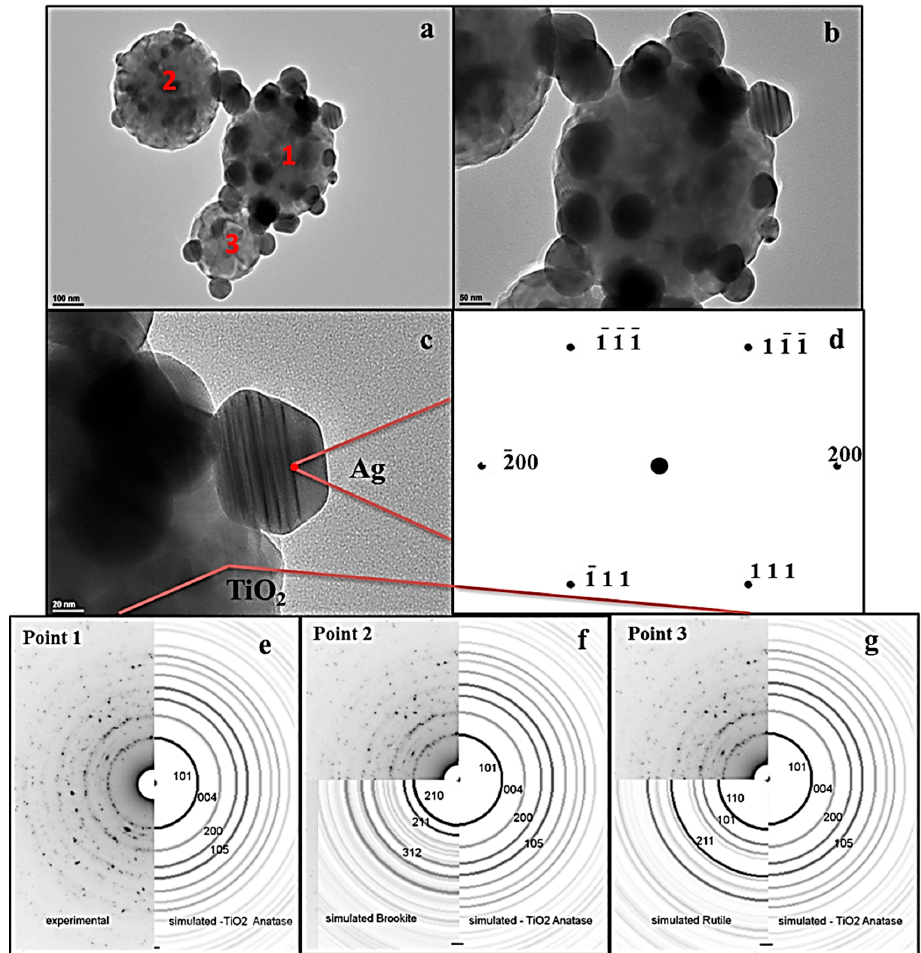
Figure 3. TEM micrographs of Ag/TiO 2 powder: ( a ) TiO 2 nanoparticles with the distributed